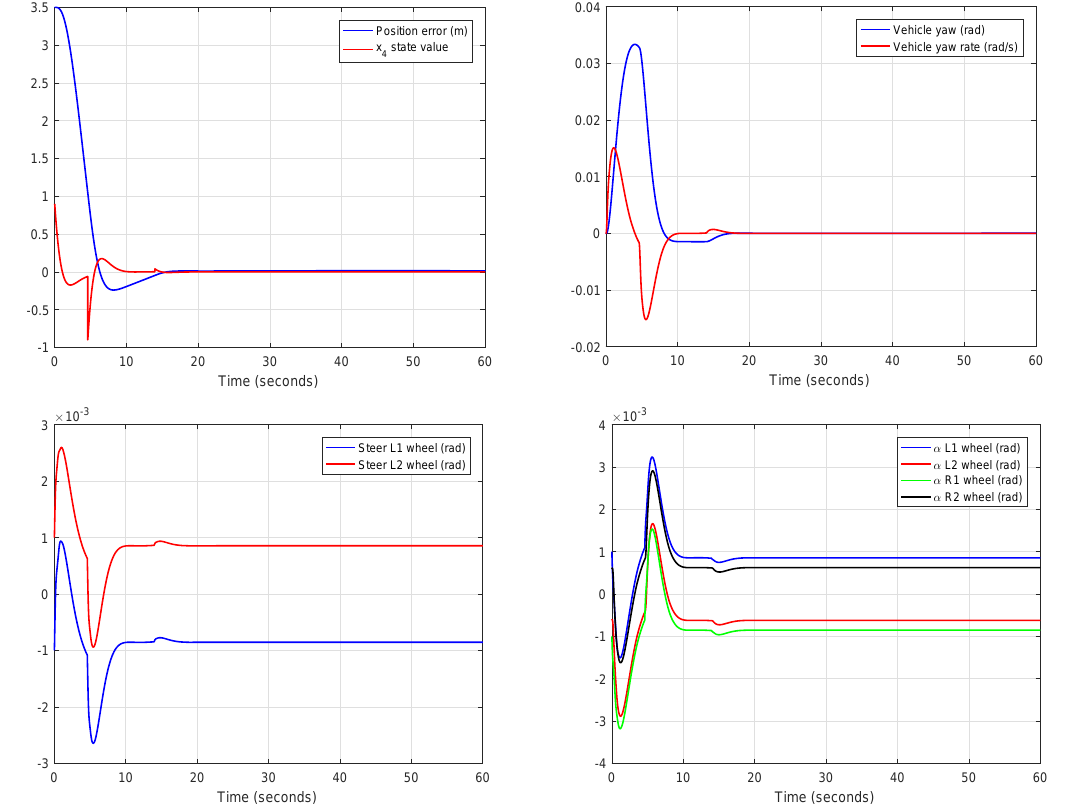
Figure 33. Detail of the experiments for the controller with variable band and optimal reset with payload at 90 km/h in